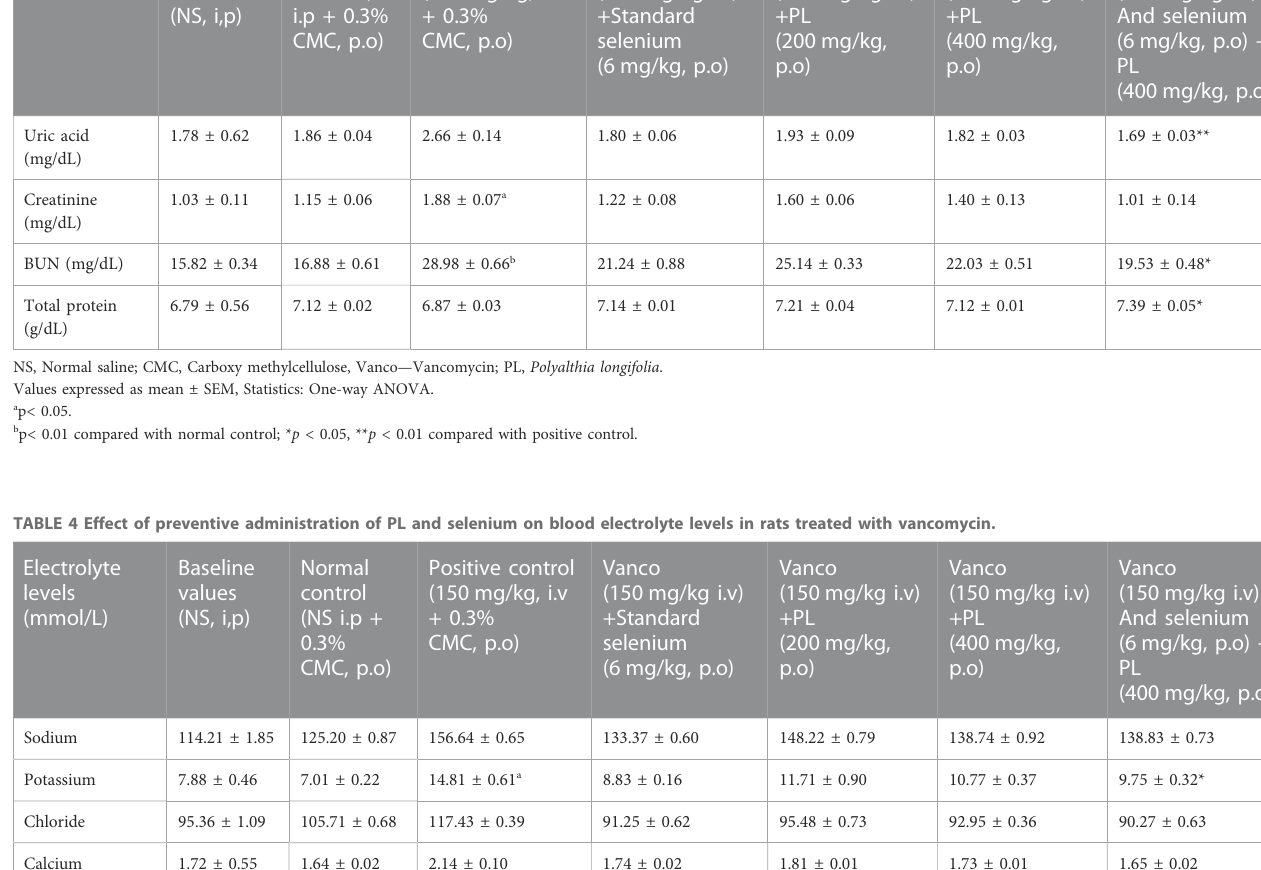
TABLE 3 Effect of preventive administration of PL and selenium on renal biomarkers in vancomycin treated rats. Renal biomarkers